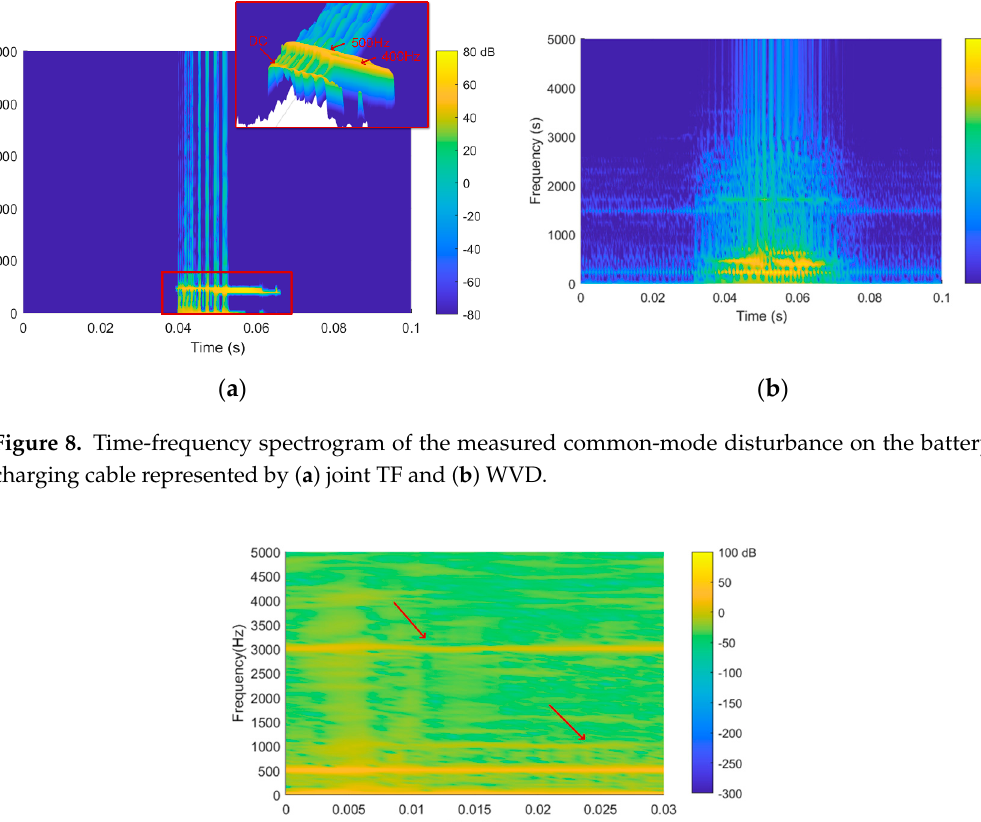
Figure 9. A zooming-in of the time–frequency spectrogram in Figure 8a.